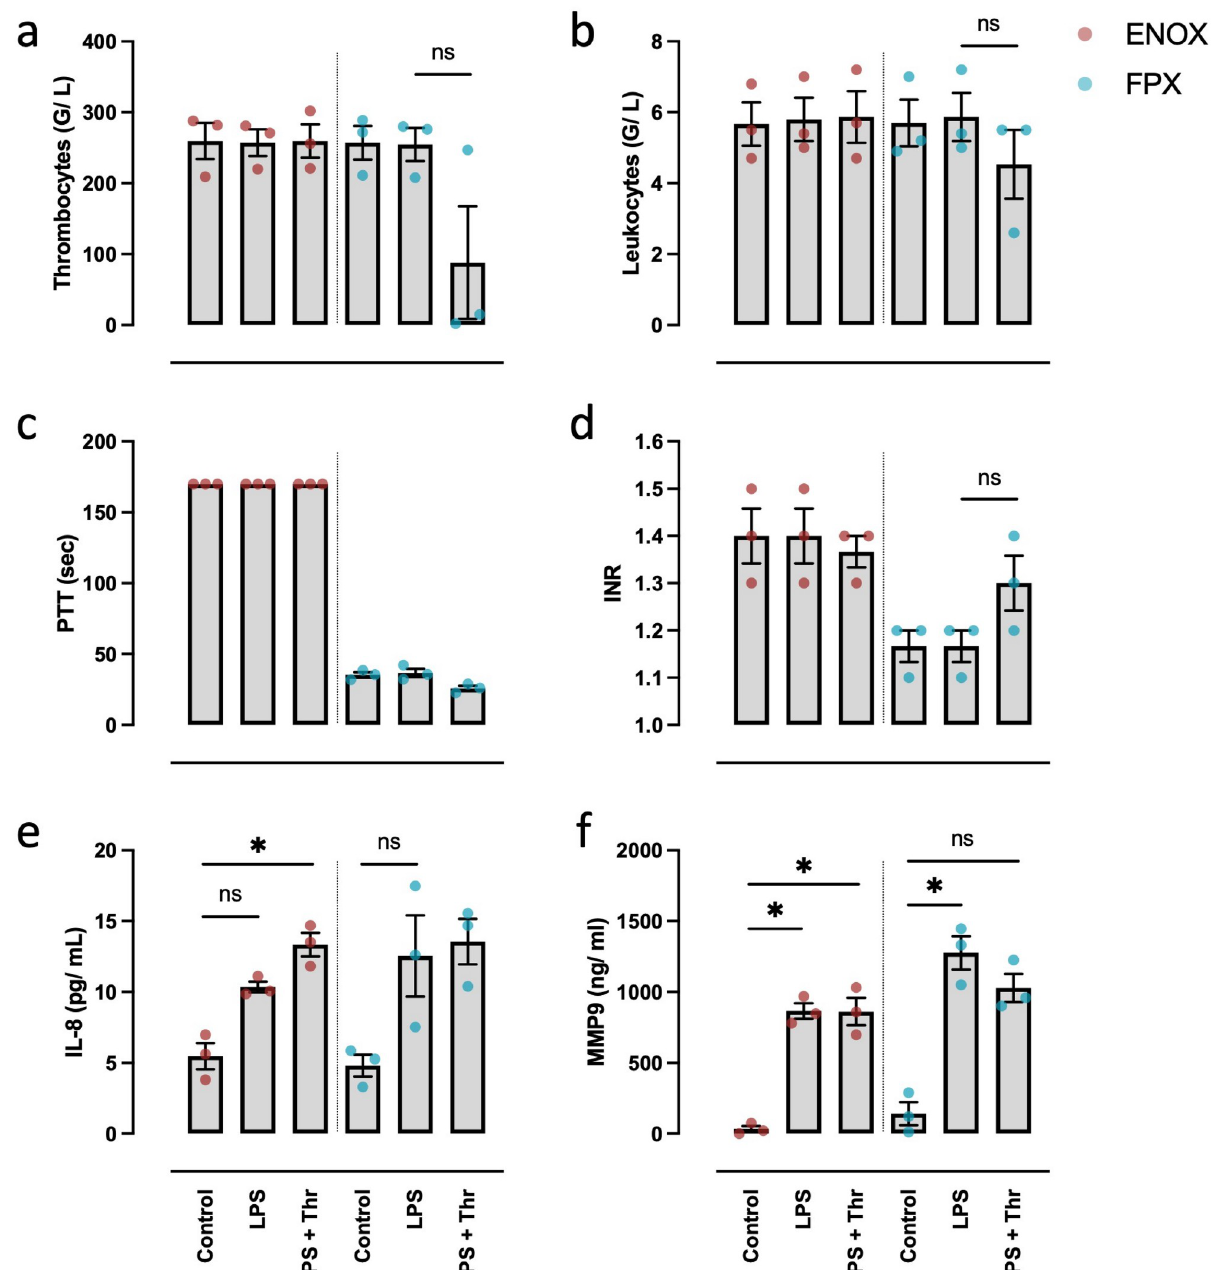
Fig 6. Effects of LPS stimulation with and without additional thrombin-driven activation of the coagulation system. Human whole blood was incubated for 30 min with either PBS (Control) or 100 ng/mL LPS plus or minus 0.5 U/mL thrombin (LPS and LPS + Thr, respectively). Thrombocyte and leukocyte counts (a,b) showed no significant changes with either stimulant, except for a slight decrease of both platelets and leukocytes when stimulated with both LPS and thrombin. The PTT remained unchanged when using the FPX protocol (c). The PTT values of the ENOX group cannot be interpreted, because they were artificially prolonged beyond the detection limit in all samples. An obtainable, yet statistically insignificant increase of the INR was observed when incubating whole blood with both LPS and thrombin using the FPX protocol (d). Both IL-8 and MMP9 were elevated after incubation with LPS in either model (e, f). Thrombin did not show a significant additional effect. For statistical analysis, RM two-way ANOVA with Geisser-Greenhouse correction was performed using Tukey’s post-hoc testing for each group (FPX and ENOX) separately. � p < 0.05. Values are presented as mean ± s.e.m. All samples: n =